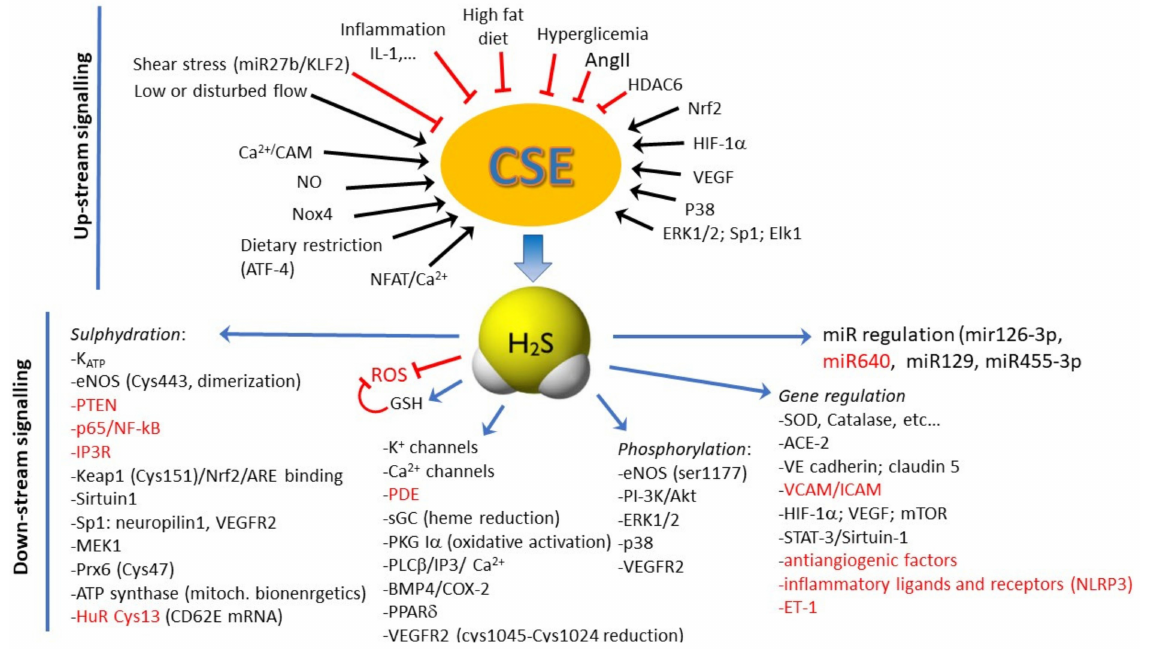
Figure 1. Summary of the molecular mechanisms controlling CSE expression and function in endothelial cells (up-stream signaling) and of the multiple downstream signaling activated or inhibited by H 2 S in ECs. Red target or lines means inhibition. Note that some signals are both up- and downstream, strengthening the central role of CSE/H 2 S in controlling vascular trophism and functions. ACE-2, angiotensin converting enzyme 2; Akt, protein kinase B; AngII, angiotensin II; ARE, antioxidant responsive elements; ATF4, activating transcription factor 4; BMP4, bone morphogenetic protein 4; cGMP, cyclic guanosine monophosphate; COX-2, cyclooxygenase-2; CSE, cystathionine γ -lyase; Elk1, ETS Like-1 protein; eNOS, endothelial NO synthase; ERK1/2, extracellular signaling regulated kinase 1 ; ET-1, endothelin-1; HIF-1a, hypoxia inducible 2 factor-1a; HuR, human antigen R; ICAM, intercellular adhesion molecule; IL-1, interleukin 1; IP3, inositol-3-phosphate; IP3R, inositol-3-phosphate receptor; K ATP , ATP-sensitive K+ channels; Keap1, Kelch-like ECH associated protein 1, KLF2, Krüppel- like Factor 2; MAPK, mitogen-activated protein kinase; MEK1, MAP kinase kinase 1; NFAT, nuclear factor of activated T-cells; NF- κ B, nuclear factor-kappa B; NLRP3, nucleotide-binding oligomerization domain, leucine rich repeat, and pyrin domain containing protein 3; NO, nitric oxide; Nox4, NADPH oxidase 4; Nrf2, nuclear factor erythroid 2-related factor 2; p38, p38 mitogen-activated protein kinases; PDE, phosphodiesterase; PI-3K, phosphoinositide 3-kinase; PKG, protein kinase G; PLC β , phospholipase C β ; PPAR δ , peroxisome proliferators-activated receptor δ ; Prx6, thioredoxin-dependent peroxiredoxin; PTEN, phosphatase and tensin homolog; sGC, soluble guanylate cyclase; SOD, superoxide dismutase; Sp1, specificity protein 1 transcription factor; STAT3, signal transducer and activator of transcription 3; VCAM, vascular cell adhesion molecule; VEGF, vascular endothelial growth factor; VEGFR2, vascular endothelial growth factor receptor